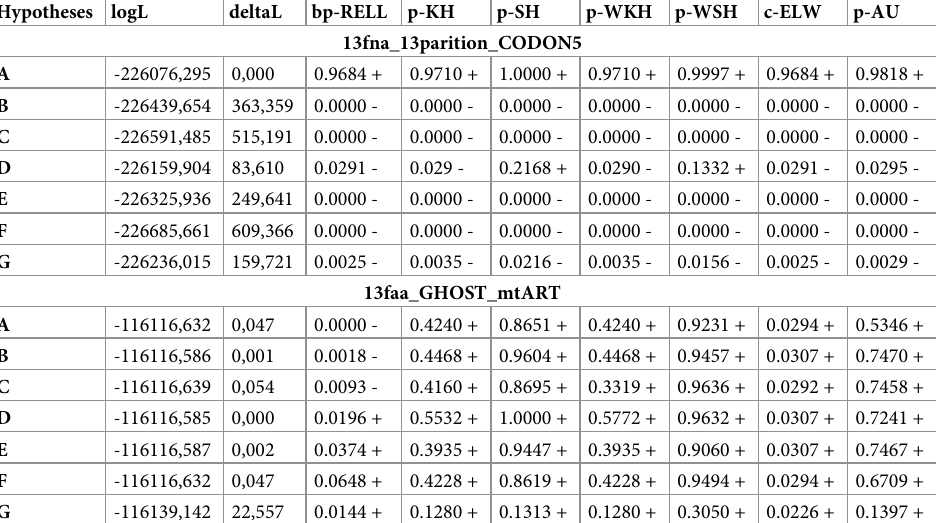
Table 3. Results of tree topology tests of the analyses 13fna_13parition_CODON5 and 13faa_GHOST_mtART. Seven hypothetical topologies were (A) best tree without any constrains; (B) Tomoceridae + Oncopoduridae; (C) Neeli- pleona + Symphypleona s. s.; (D) Tomoceroidea + (Entomobryoidea + Isotomidae); (E) Tomoceroidea + Poduromor- pha; (F) Tullbergiidae + Onychiuridae; (G) Symphypleona s. s. +